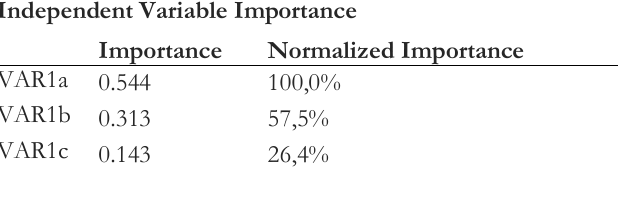
Table 3. Independent variabl e ımportance for classical item 1 in terms of neutrosophic items .